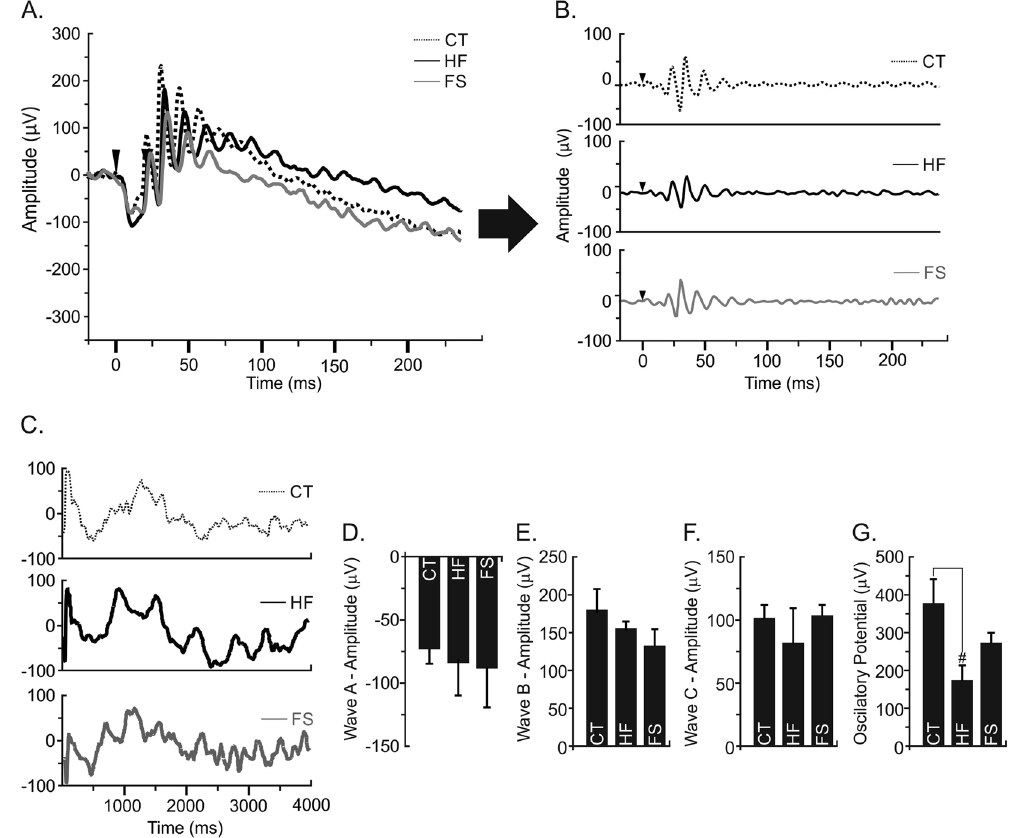
Figure 3. Retinal Electroretinography Responses (RER). ( A ) Representative image of waves A and B from RER on different experimental groups. ( B ) Representative image of the oscillatory potential at 0.25 cd.s/m 2 in experimental groups. ( C ) Representative image of waves C. ( D ) Wave A amplitude. ( E ) Wave B amplitude. ( F ) Wave C amplitude. ( G ) Oscillatory potential. In all experiments, n = 6; # P < 0.05 vs.